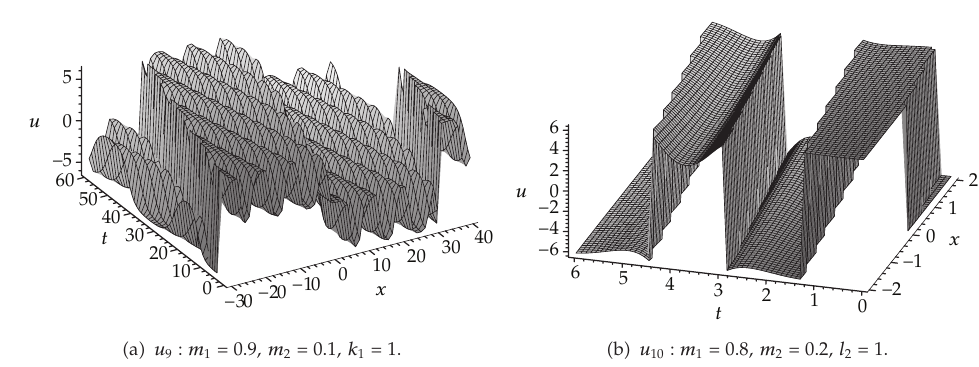
Figure 2: Two special cases of the solutions u 9 (cid:2) a (cid:3) and u 10 (cid:2) b (cid:3)